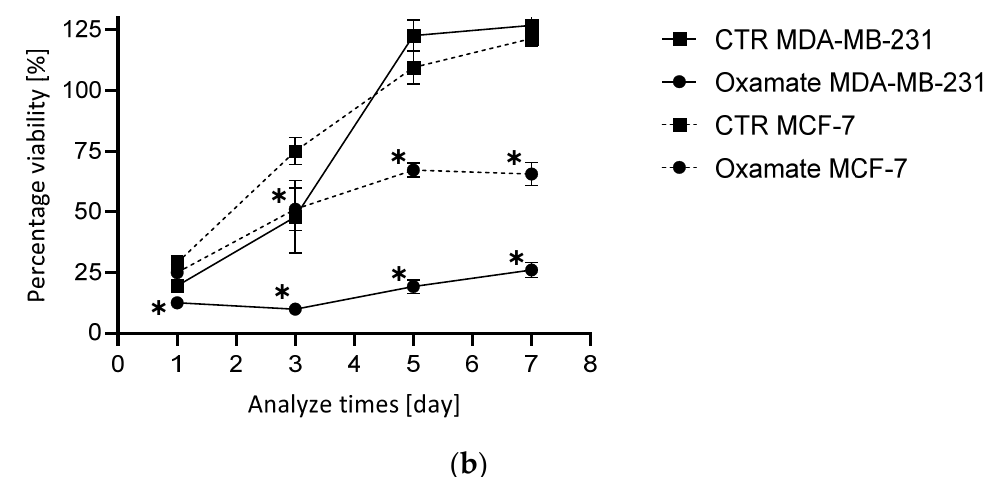
Figure 2. Metabolic inhibitor evaluation. ( a ) Viability test (crystal violet staining) after 72 h. Black: MDA-MB-231, Grey: MCF-7 and Hatched: MCF-10; CTR: control condition. A: AZD3965, B: 3-bromopyruvate, C: Chrysin, Cb: CB-839, D: D609 and O: Oxamate; n = 6, average ± SD, significance: * p < 0.05. ( b ) Proliferation test (crystal violet staining) during 7 days of measuring at days 1, 3, 5 and 7 of the cells treated with Oxamate 50 mM. Full lines: MDA-MB-231 and Hatched lines: MCF-7; n = 6, average ± SD, significance: * p < 0.05.